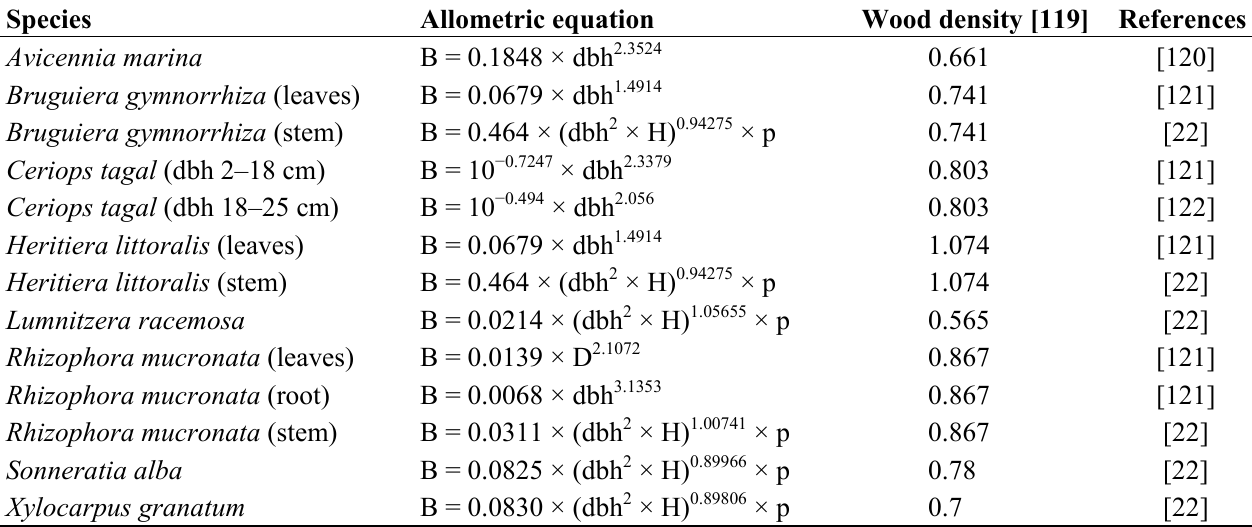
Table 2. Allometric equations employed for calculating above-ground biomass (B). dbh refers to diameter at breast height; D represents diameter; H stands for height; p = wood